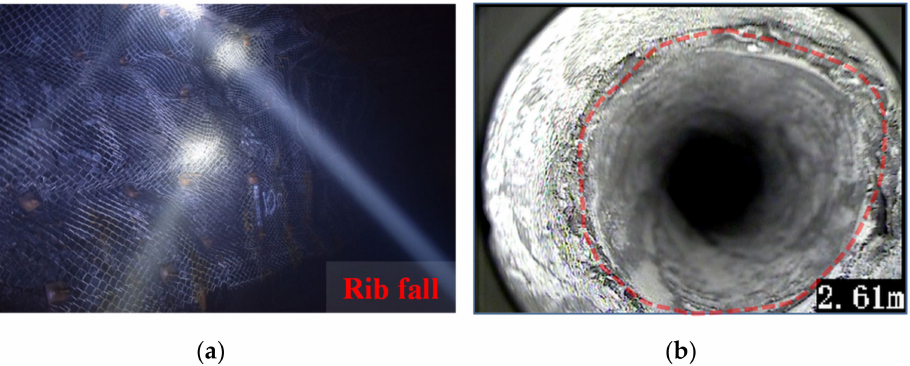
Figure 4. Maintenance effect of roadway: ( a ) rib fall; ( b ) separation fracture outside the roof bolt anchorage